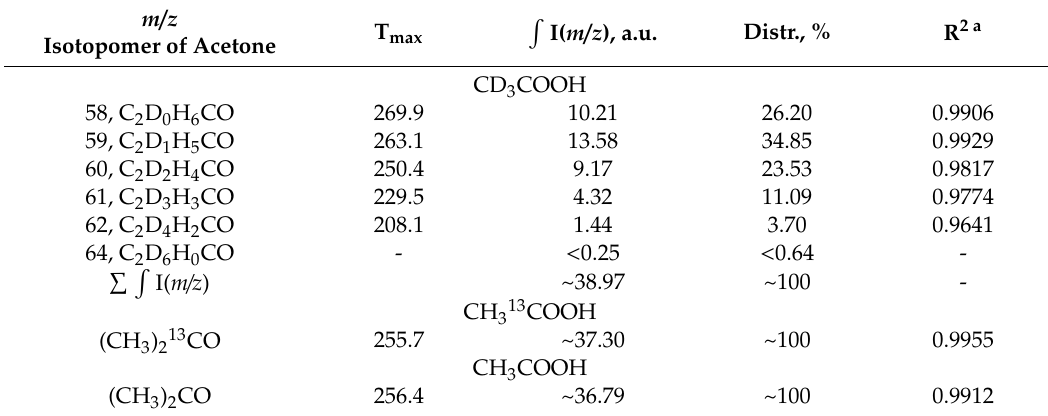
(cid:82) I( m / z )) and distribution